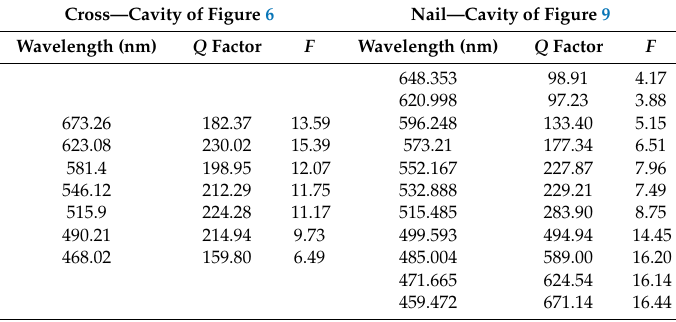
Table 1. Calculated quality ( Q ) factor and finesse ( F ) for each wavelength in the cross and the nail structures. In order to compare the results from the di ff erent types of structures, data were centered at 515 nm, which was a common peak. Cross—Cavity of Figure 6 Nail—Cavity of Figure